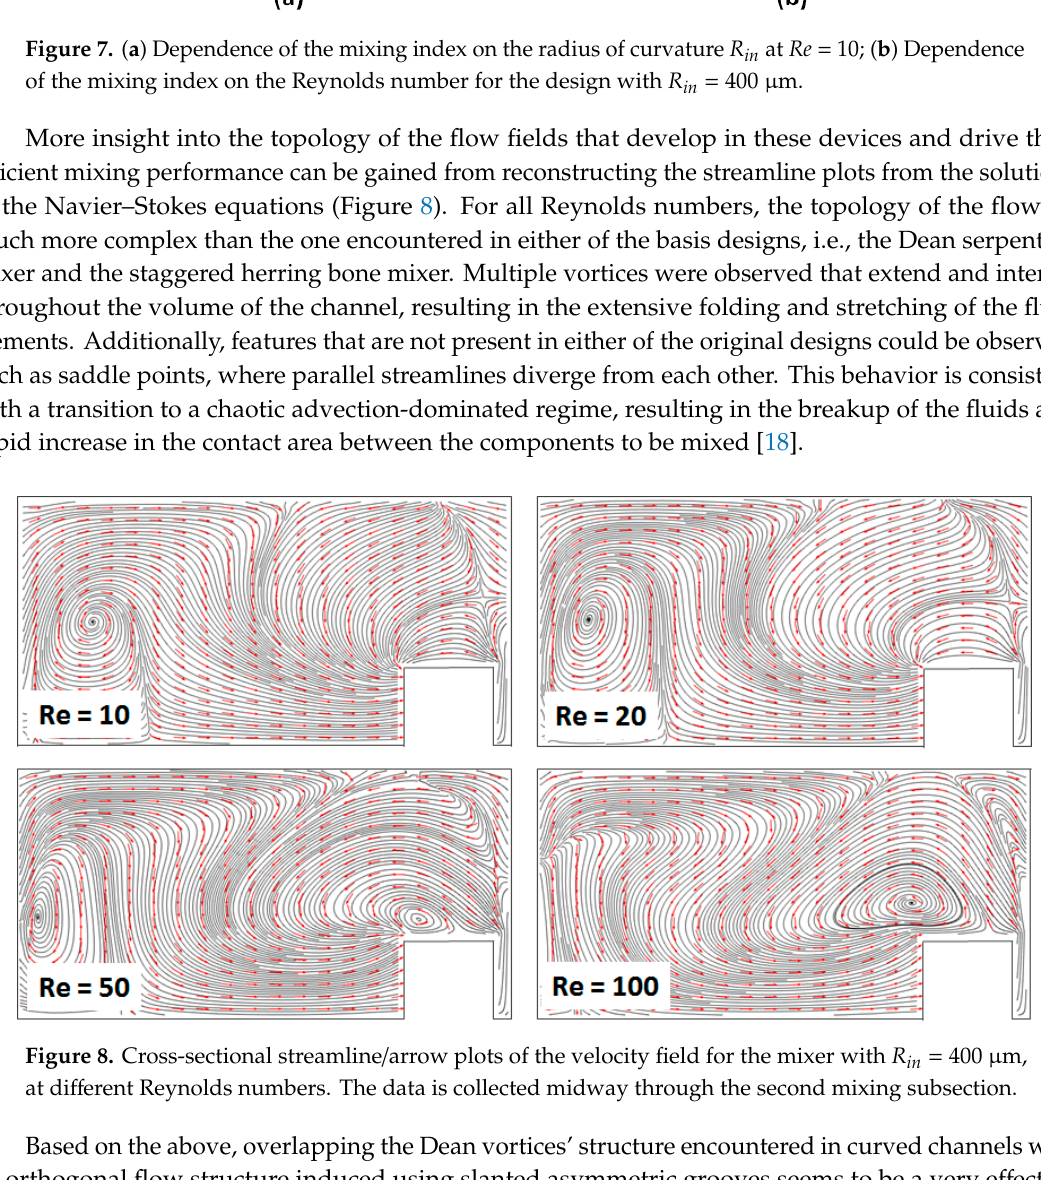
Figure 8. Cross-sectional streamline/arrow plots of the velocity field for the mixer with R in = 400 μ m, at different Reynolds numbers. The data is collected midway through the second mixing subsection.